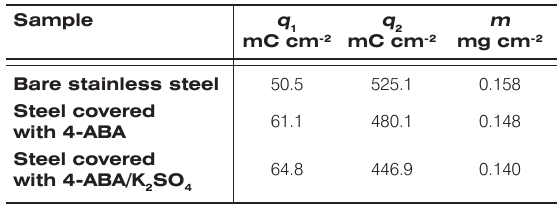
Figure 12. Chronoamperometric curves for stainless steel recorded in 0.25 mol dm -3 K (a) for bare stainless steel, (b) sample covered with 4-ABA/K Table 2.